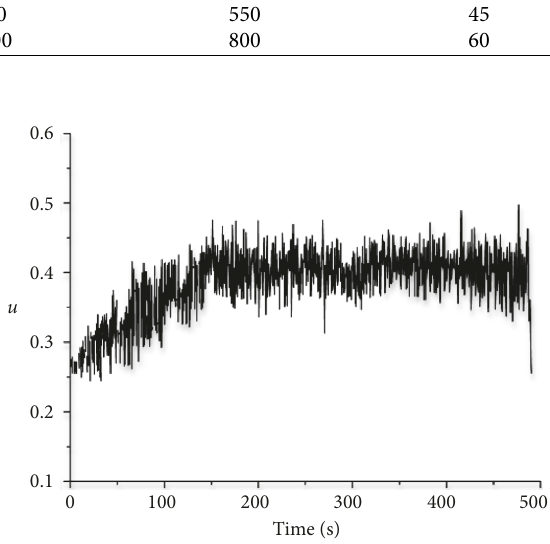
Figure 7: Distribution of friction coefficient for part